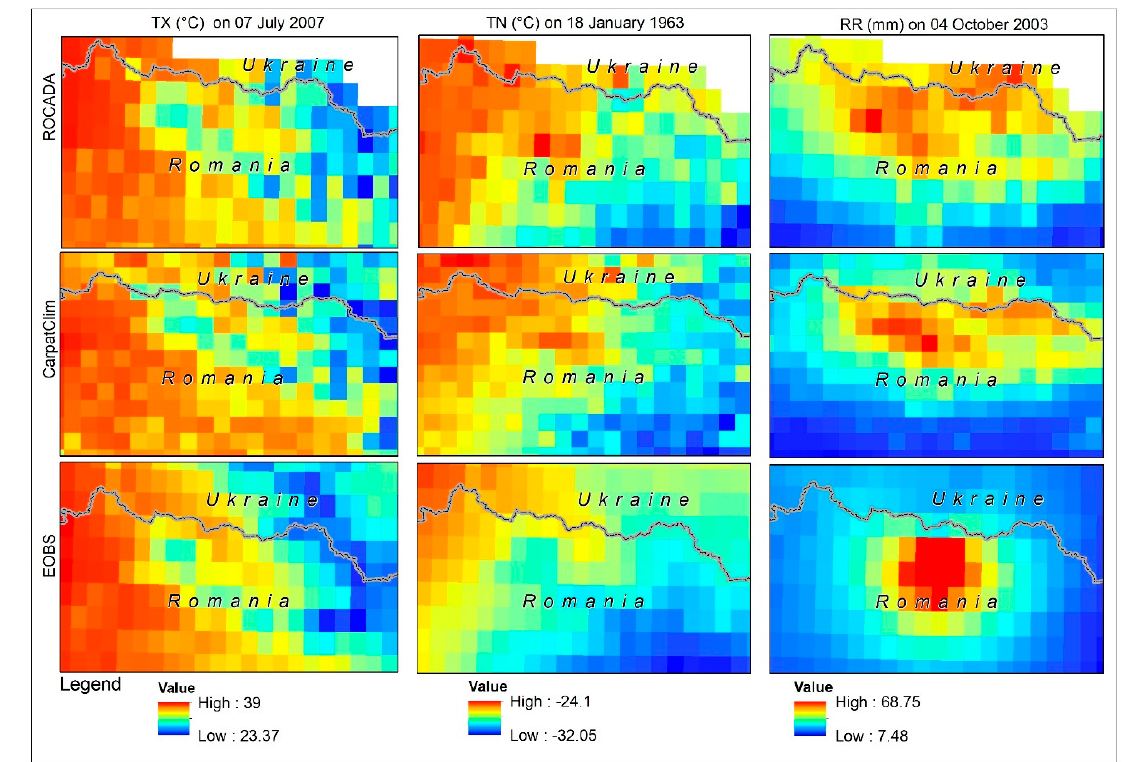
Figure 3. Spatial distribution of the historical maximum temperature (TX), minimum temperature (TN), and precipitation (RR) values in the focus region.